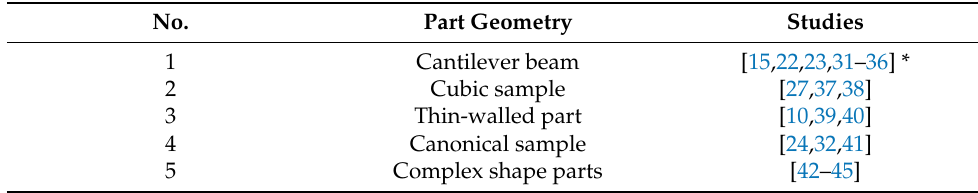
Table 1. Previous studies of part-scale model in SLM process. Reprinted with permission from refs. [10,15,22–24,27,31–45]. Copyright 2022 Elsevier. No. Part Geometry Studies 1 Cantilever beam [15,22,23,31–36] * 2 Cubic sample [27,37,38] 3 Thin-walled part [10,39,40] 4 Canonical sample [24,32,41] 5 Complex shape parts